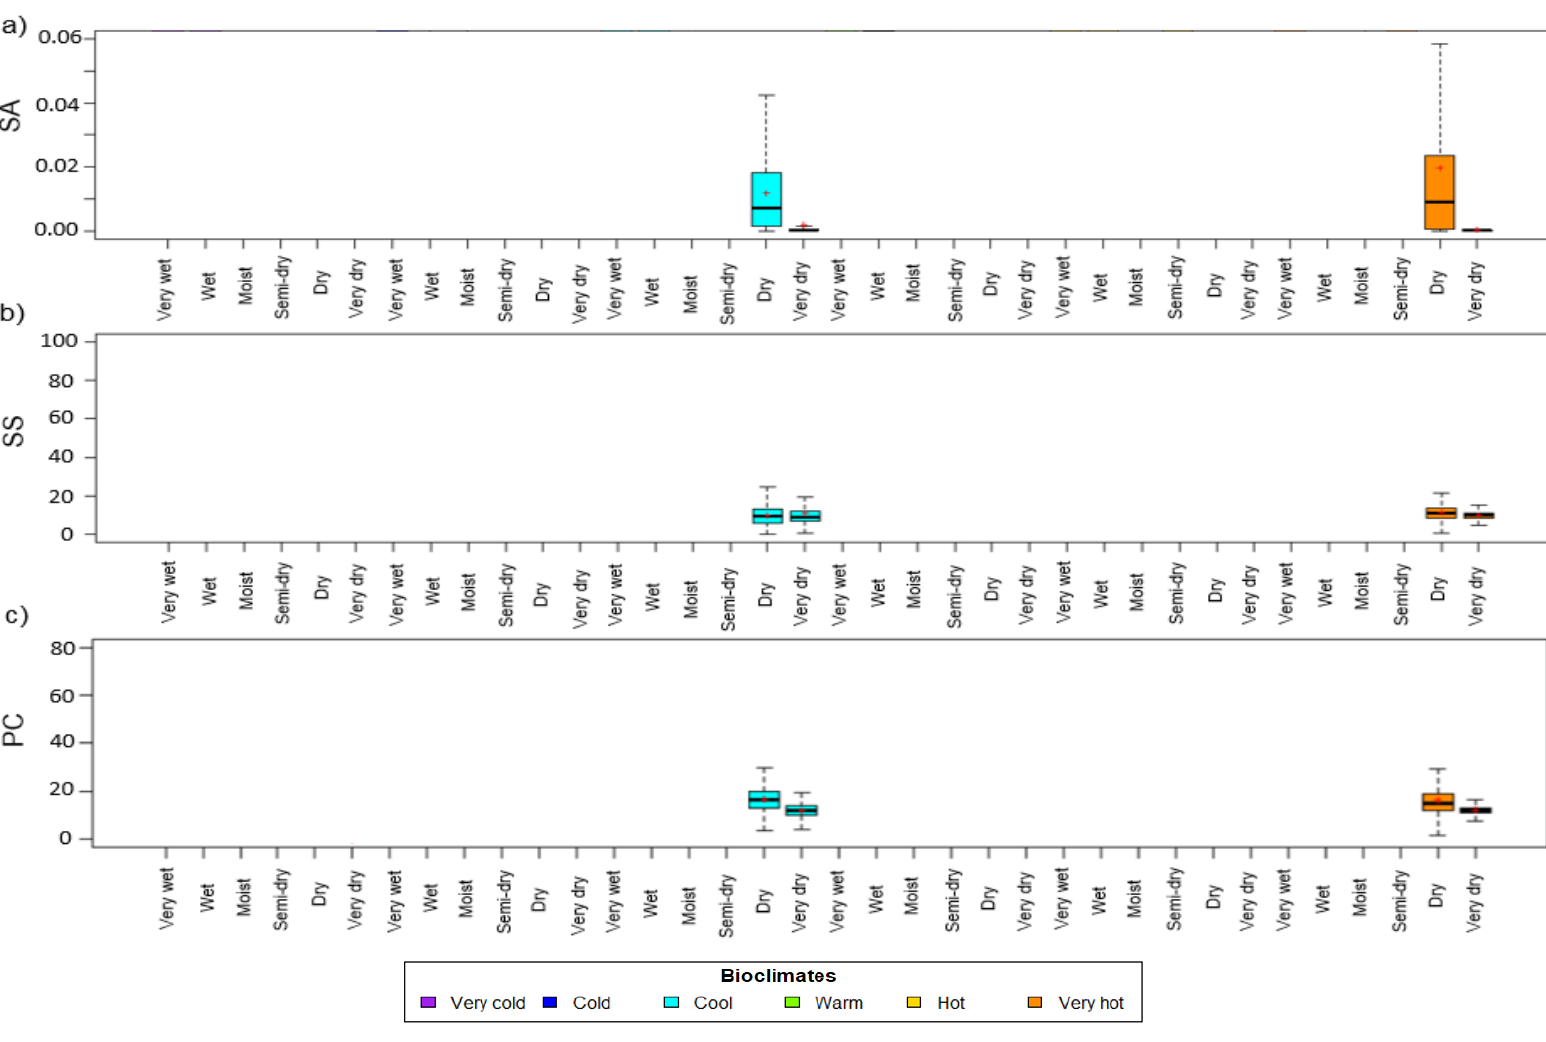
Figure 6. ( a ) Boxplots of the seasonality amplitude, ( b ) seasonality stability ( c ) and the pluri-annual cycles indicator of ecosystems with trimodal seasonal pattern per each bioclimate.